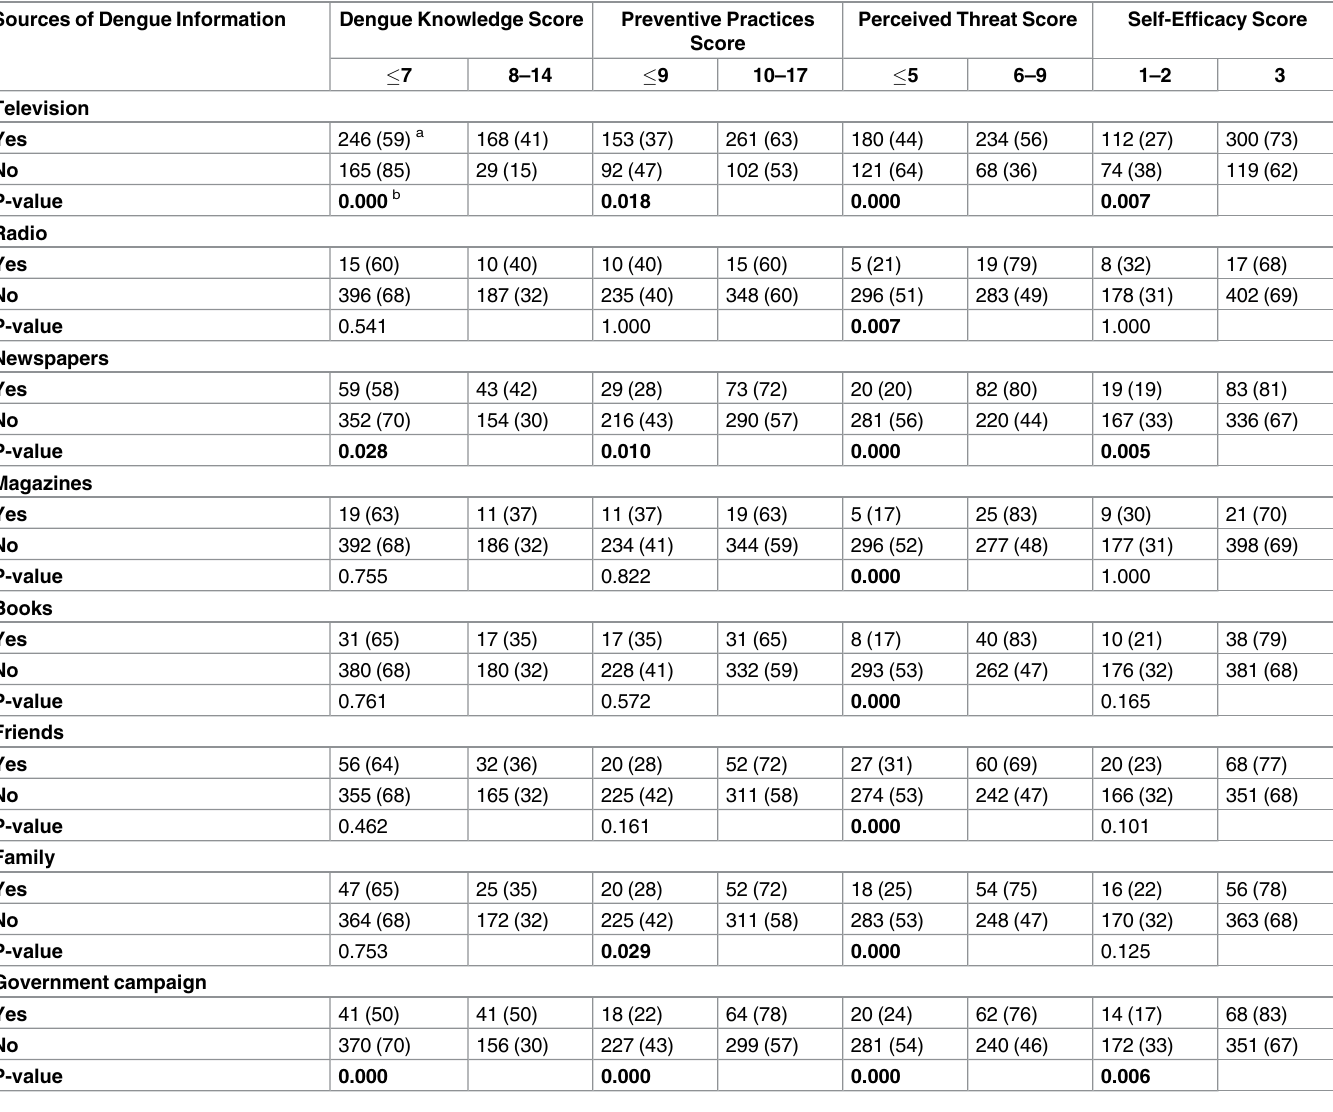
Table 1. Associations of Information Sources with Dengue Knowledge, Preventive Practices, PerceivedThreat, and Self-Efficacy. Sources of Dengue